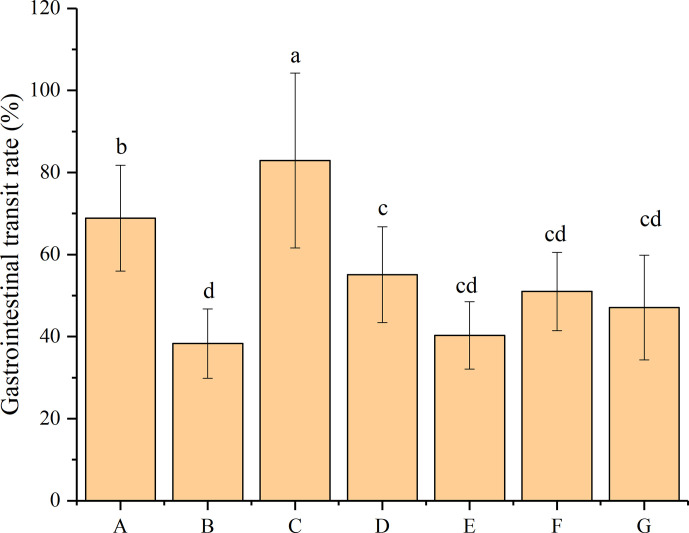
Gastrointestinal transit rate of BALB/c mice after constipation induced by loperamide hydrochloride and administration of different treatments (n = 10). (A) Normal control: no treatment; (B) negative control group: physiological saline; (C) positive control group: phenolphthalein (70 mg/kg body weight); (D) treatment group: P. acidilactici CCFM28 strain; (E) treatment group: P. acidilactici CCFM18 strain; (F) treatment group: P. acidilactici NT17-3 strain; (G) treatment group: P. acidilactici 102H8 strain. The letters a, b, c and d indicate significant differences (P < 0.05) as determined using Duncan’s multiple range test.